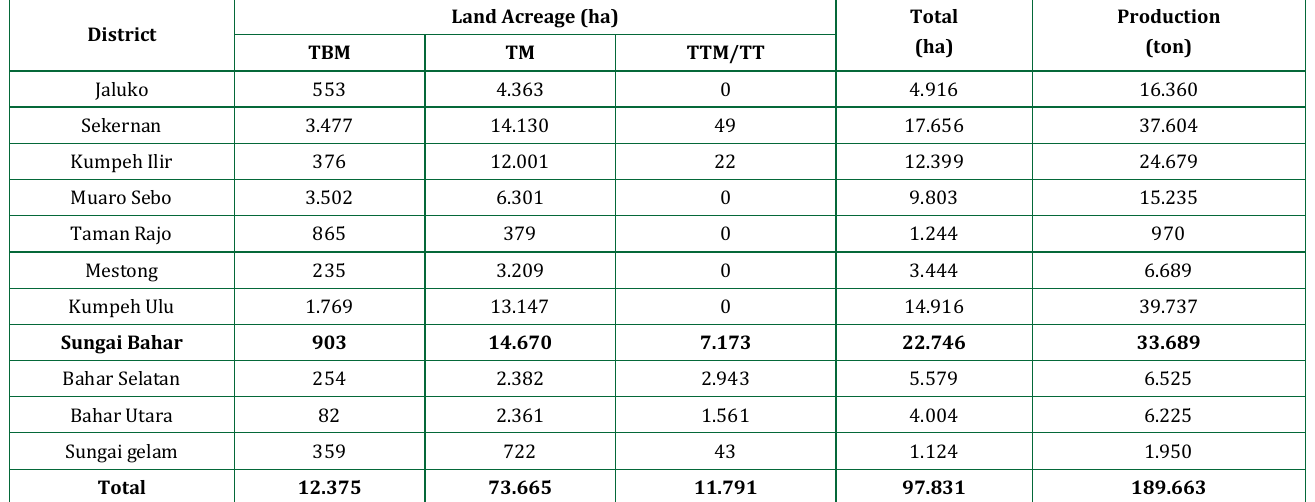
Table 3: Land Acreage of Smallholders Oil Palm based on Sub-district in Muaro Jambi District, Year of 2019 District